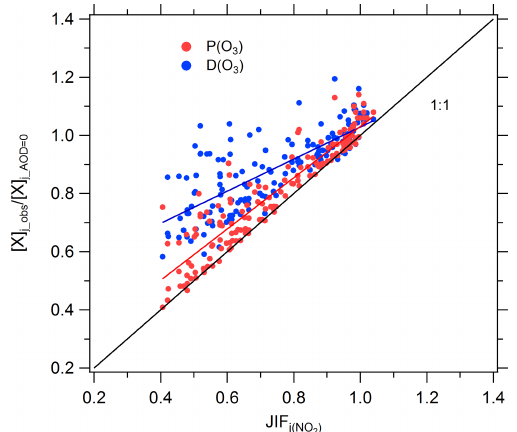
Figure 9. Correlation between P( O 3 ) j _obs /P( O 3 ) j _AOD = 0 (or D( O 3 ) j _obs /D( O 3 ) j _AOD = 0 ) and JIF of j (NO 2 ). Single data points represent daytime hourly mean values.